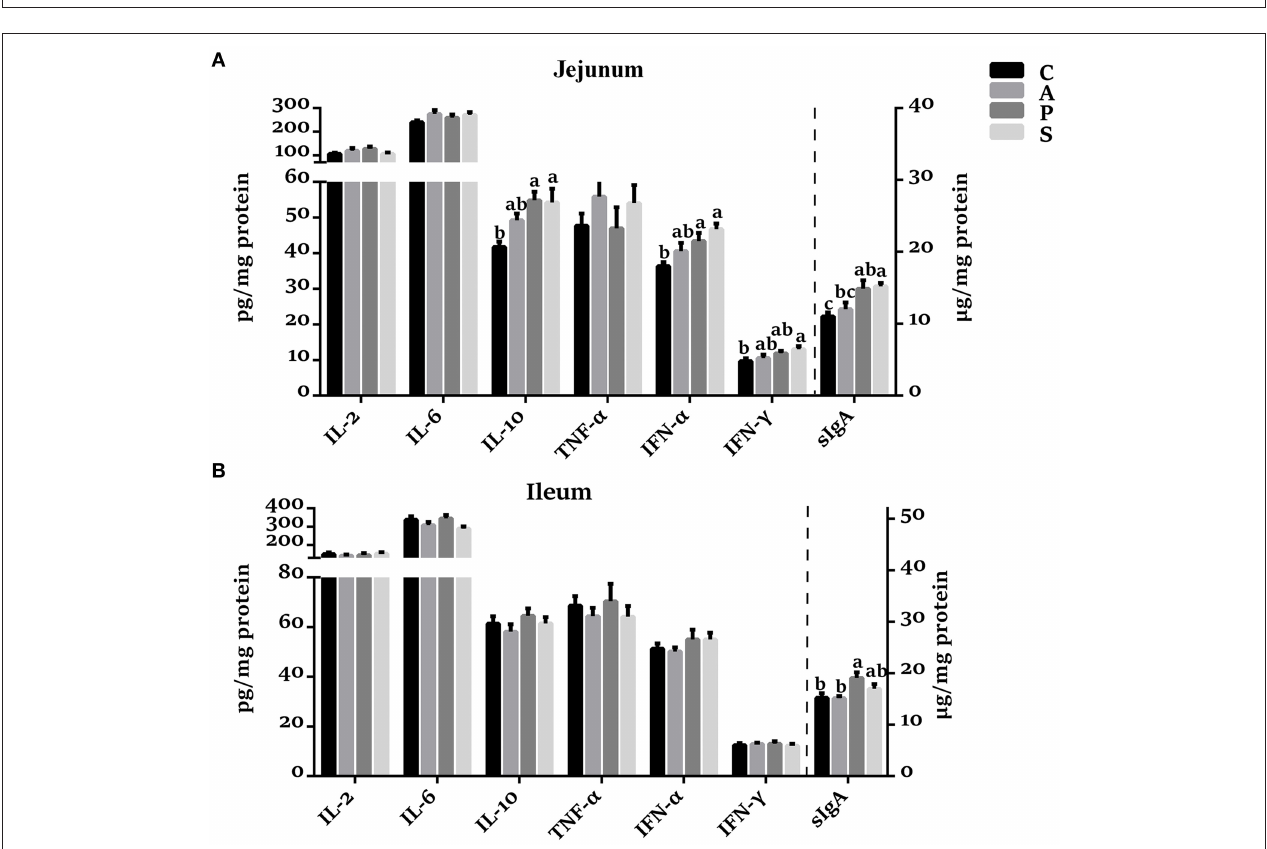
FIGURE 2 | Effects of maternal probiotic or synbiotic supplementation on the concentrations of cytokines and sIgA in the (A) jejunum and (B) ileum of offspring piglets. Data are represented as means ± SEM, n = 8 per group. Different letters indicate significant differences among the groups ( P < 0.05). IL, Interleukin; TNF- α , Tumor necrosis factor-alpha; IFN, Interferon; sIgA, secretory immunoglobulin A; C, control group; A, antibiotic group; P, probiotic group; and S, synbiotic group.